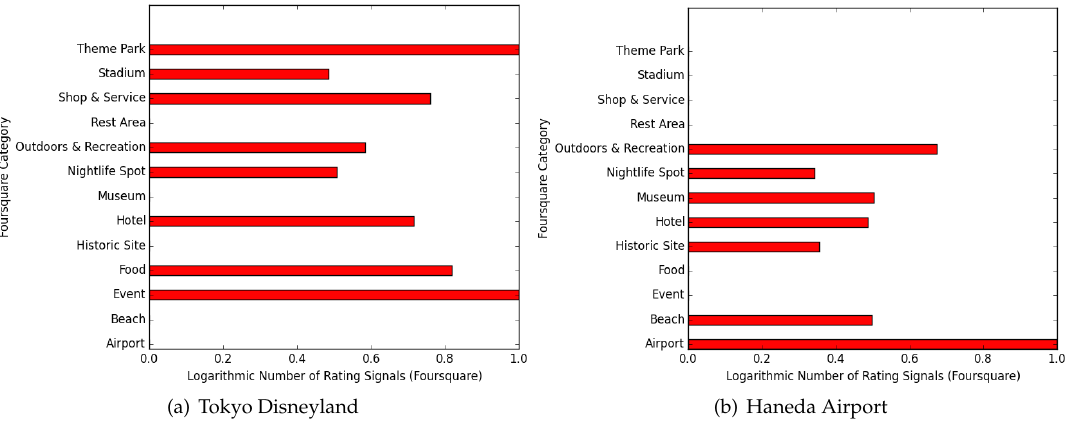
Figure 9. Examples of characteristics calculated on the basis of information about points of interest (POIs) in the